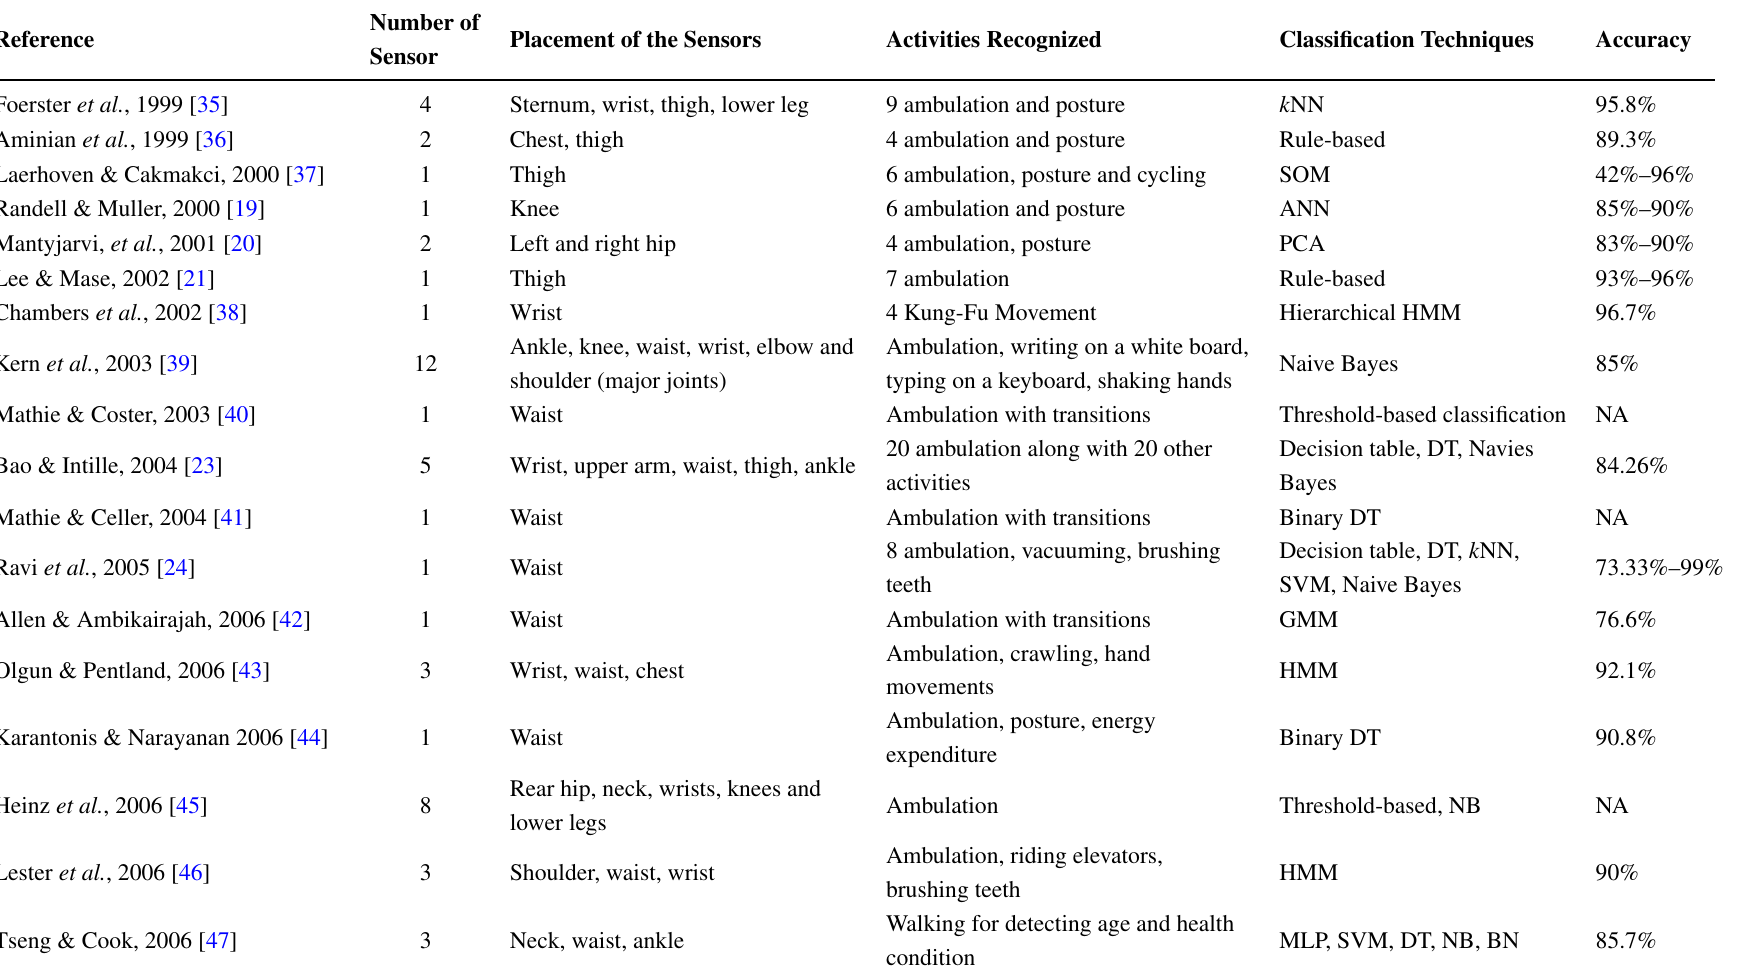
Table 2. Summary of past work on activity recognition using accelerometers (The recognition accuracies values for references without explicit statements have been marked: